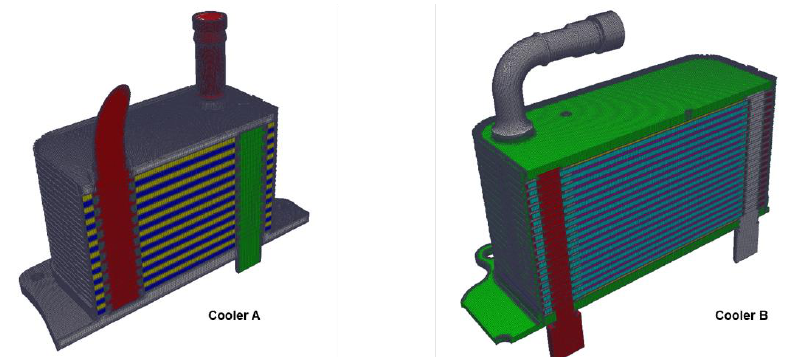
Figure 14. Computational grids generated for the two coolers.